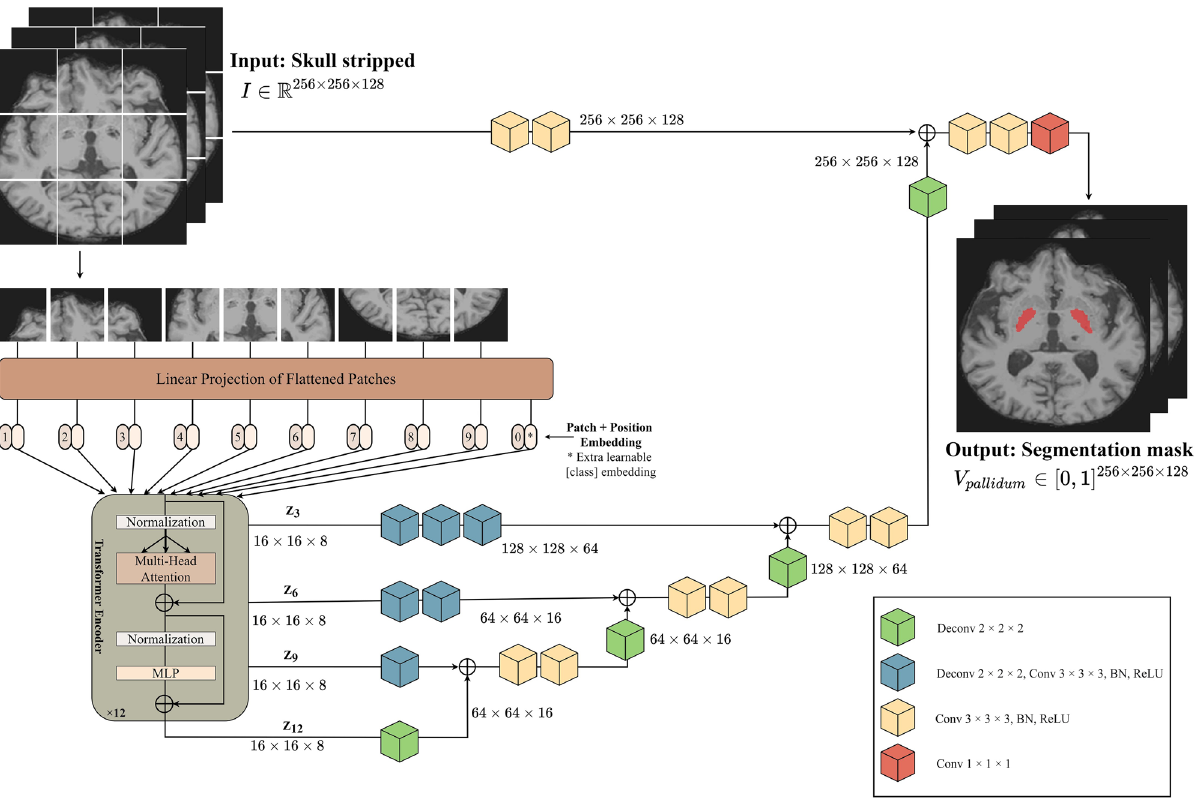
Figure 4. Architecture of ViT-based UNETR directly connected to a CNN-based decoder via skip connections at different resolutions for segmentation. ( Deconv deconvolution layer, Conv convolution layer, BN batch normalization, MLP multilayer